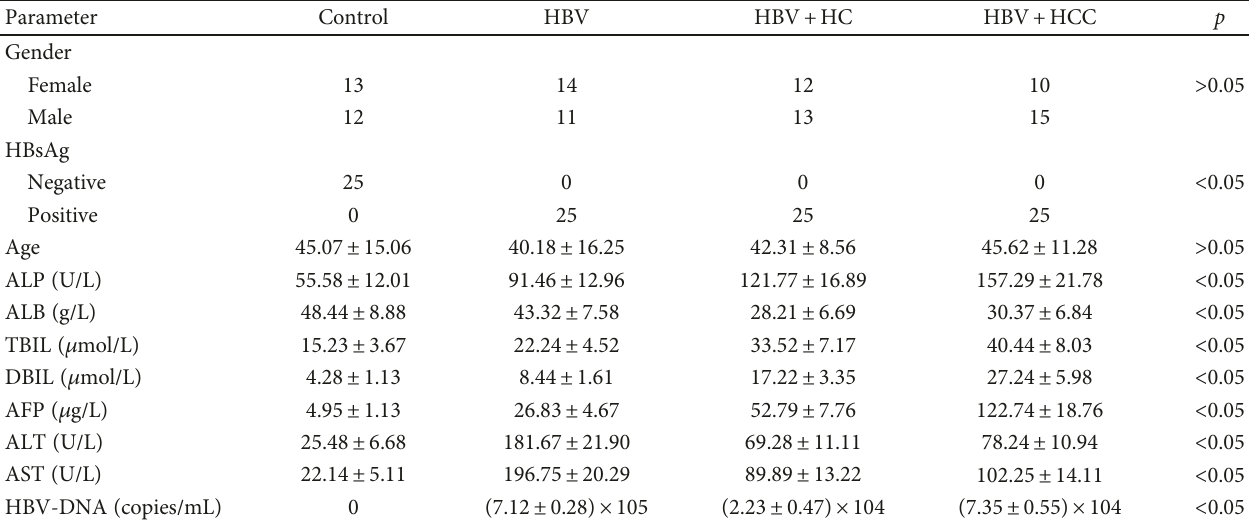
Table 1: Clinical features of